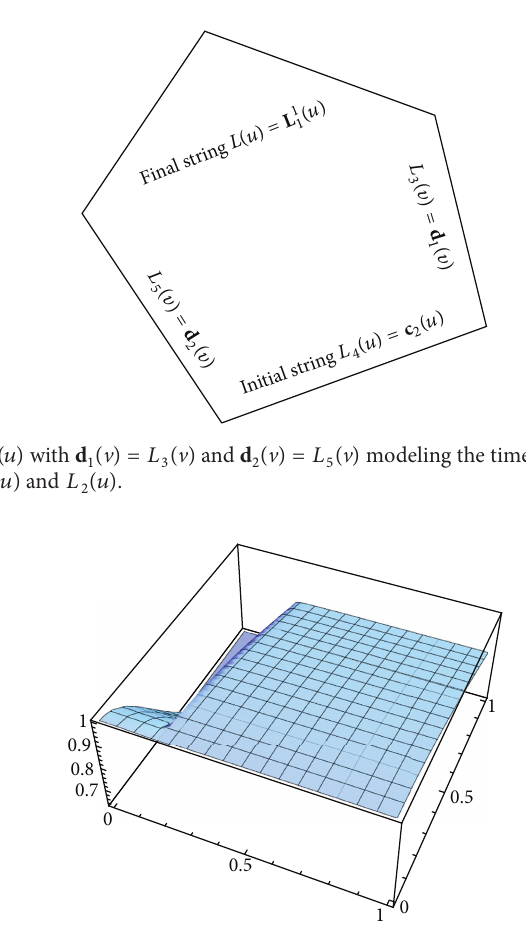
Figure 6: Cosine of the angle between N and k is positive shown for Coons patch in particular for 𝑥 𝑖 = 4 . Thus angle between N and k remains within the range 0 ≤ 𝜗 ≤ 𝜋/2